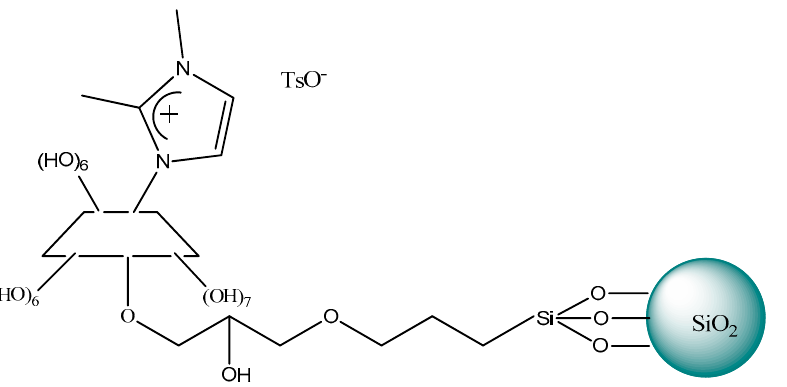
Figure 14. Functionalized ionic liquid-bonded chiral stationary phases: mono-6-deoxy-6-(1,2-dimethylimidazolium)- β -cyclodextrin tosylate CSP (adapted from Zhou, 2010) [198].